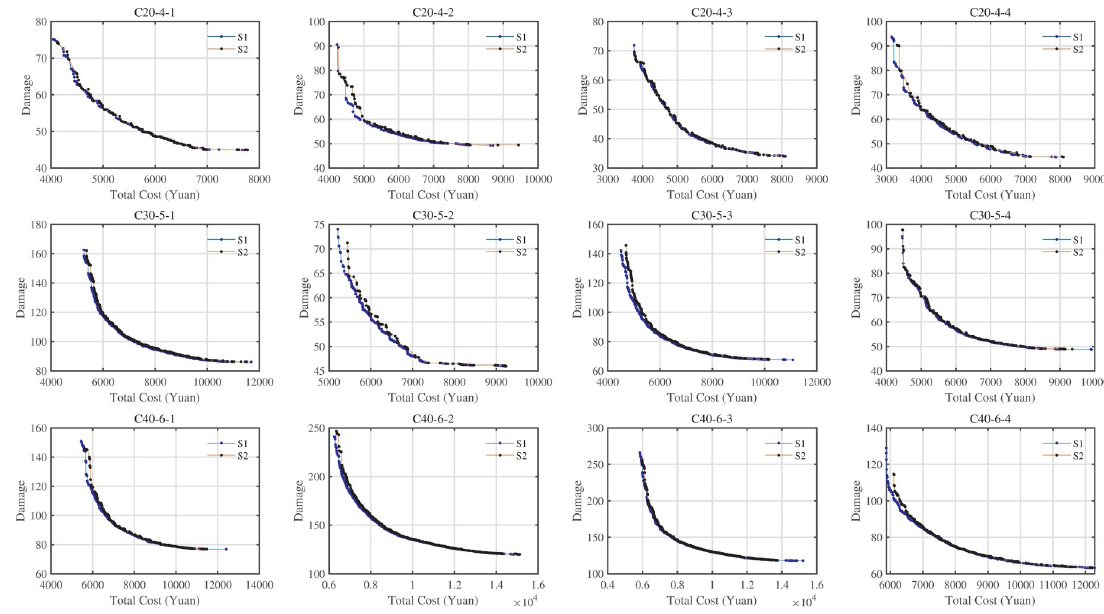
Fig 5. Pareto fronts of instances using S1 and